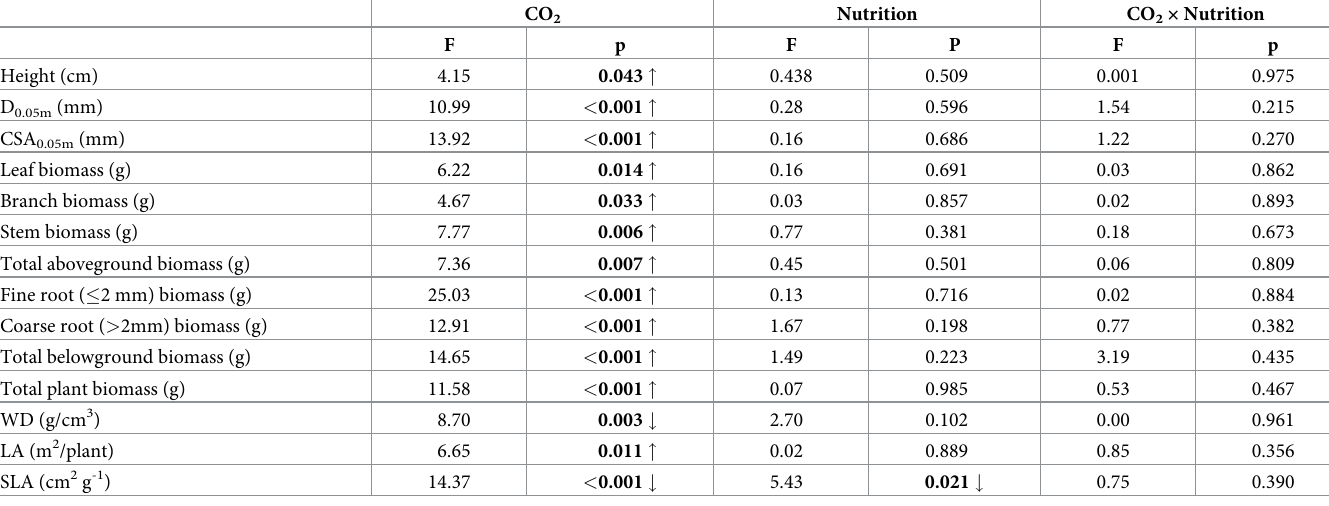
Table 1. Two-way analysis of variance (ANOVA) of the influence of CO 2 , nutrient supply and their interactions on sessile oak saplings aboveground and below- ground biometrical